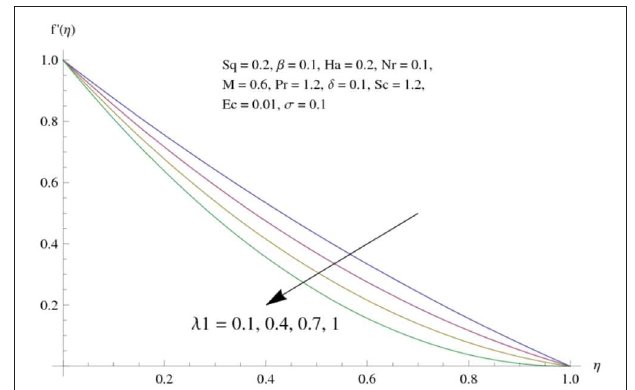
FIGURE 4 | Behavior of λ 1 on f ′ ( η ).